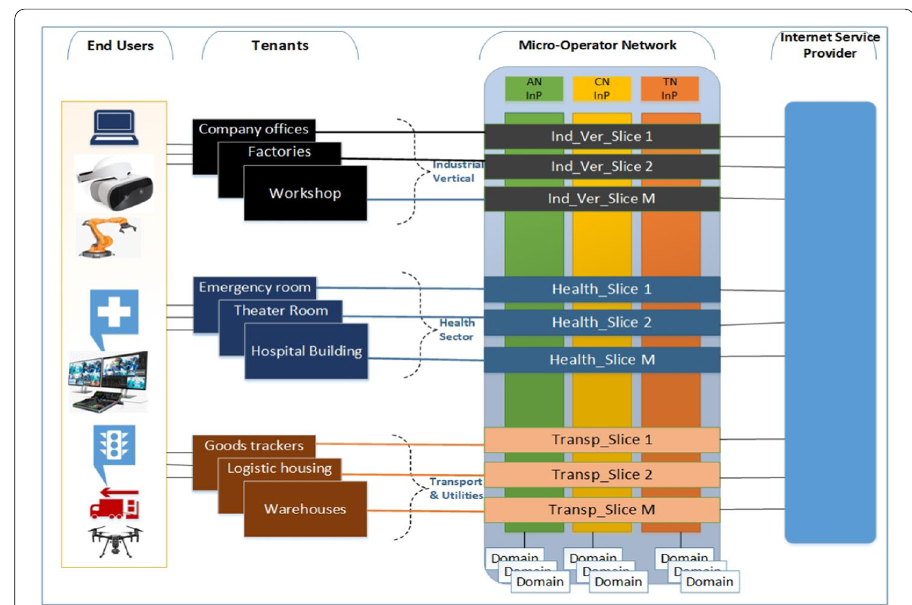
Fig. 1 General micro‑operator model [11]. This figure describes the overall model for a 5G micro‑operator network considering all key elements such as the end users, tenants, verticals, and the micro operator network